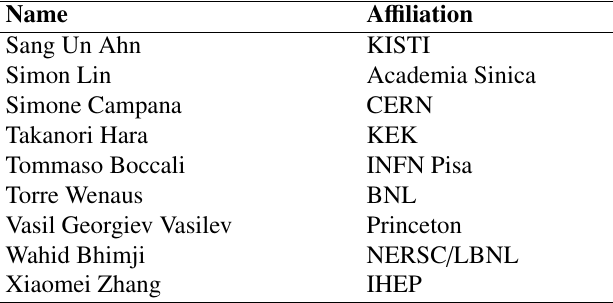
Table 4: CHEP 2019 International Advisory Committee Name